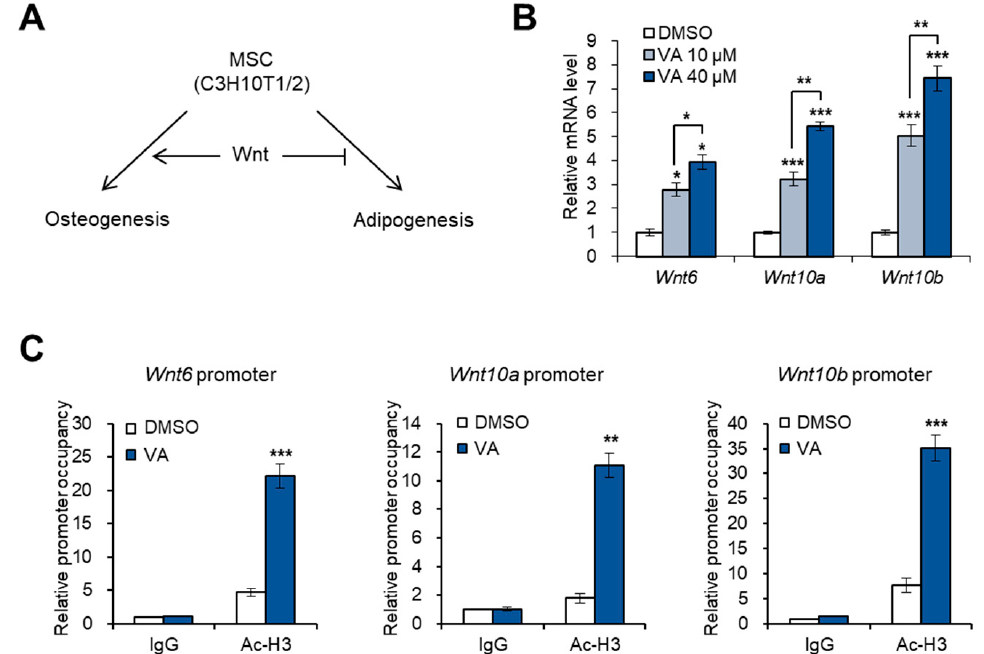
Figure 2. Vulpinic acid promotes the expression of Wnt genes via H3 acetylation in 10T1 / 2 MSCs. ( A ) Schematic representation of Wnt signaling-mediated cell fate determination of mesenchymal stem cells (MSCs). ( B ) The mRNA levels of Wnt6, Wnt10a, and Wnt10b genes in 10T1 / 2 cells treated with vulpinic acid (10 or 40 µ M) for 24 h. ( C ) 10T1 / 2 cells were treated with or without vulpinic acid (40 µ M) for 24 h. ChIP assay was performed with IgG and acetylated H3 antibodies followed by real time PCR with primers for promoter regions of Wnt6, Wnt10a, and Wnt10b genes. Data represent means ± SEM for n = 3. * p < 0.05, ** p < 0.01, *** p < 0.001.